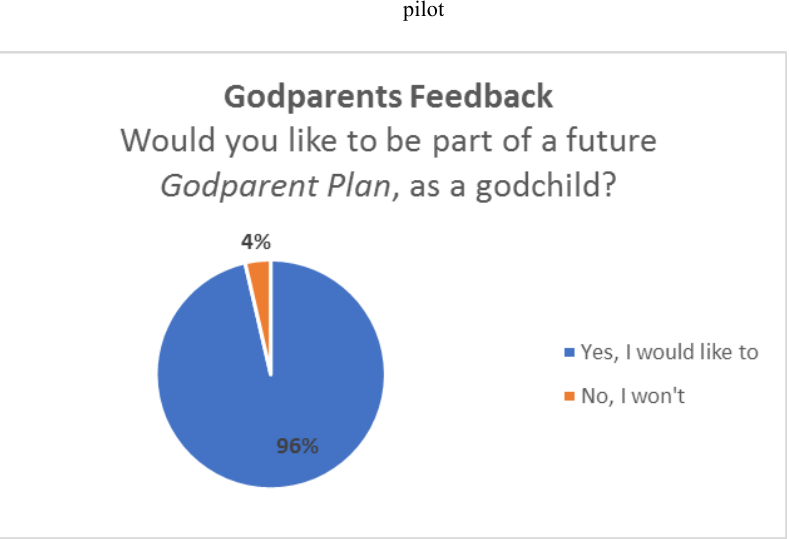
Fig. 4. Godparents’ appreciation towards how much they learnt through the Godparent Plan